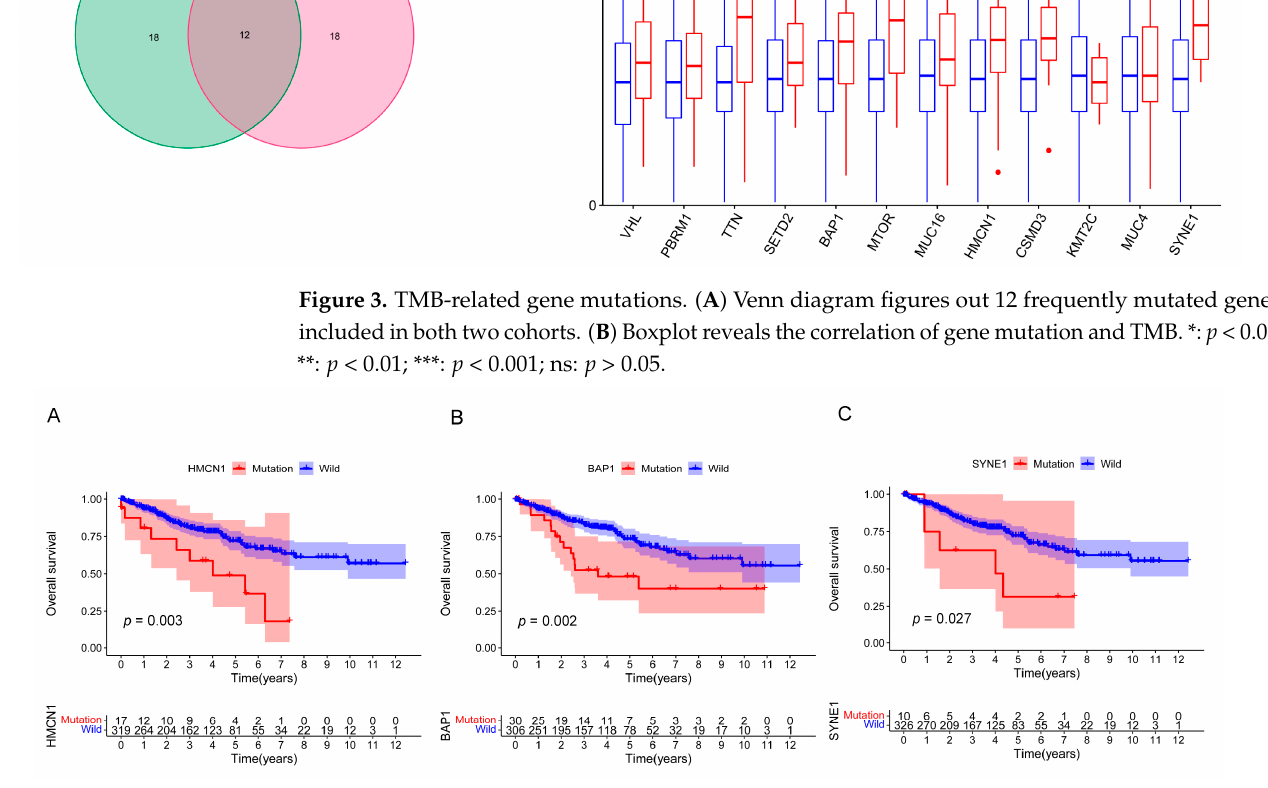
Figure 4. Gene mutations associated with prognosis. Kaplan–Meier survival curves of three gene mutations significantly correlated with clinical prognosis. ( A ): HMCN1 mutation is associated with poorer prognosis; ( B ): BAP1 mutation is associated with poorer prognosis; ( C ): SYNE1 mutation is associated with poorer prognosis.